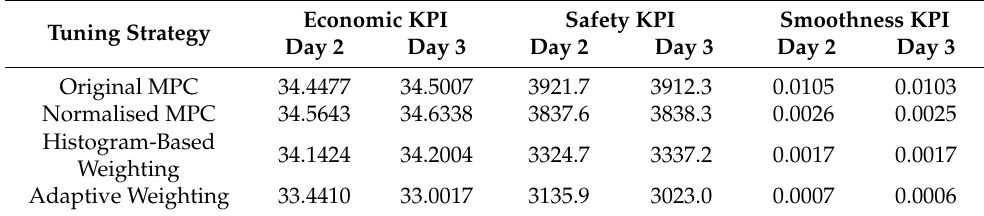
Figure 7. Disturbances, selected weights and regression models. Table 6. Tuning Strategies